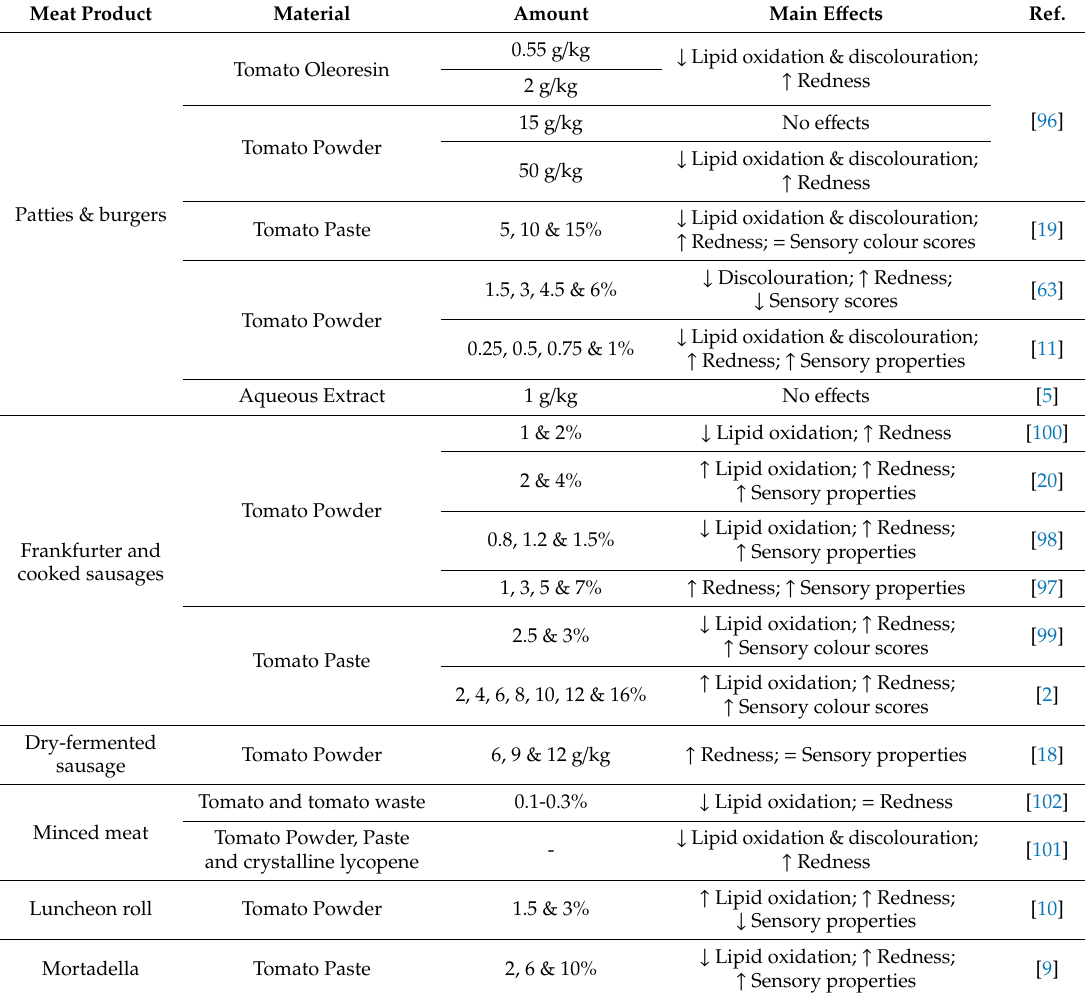
Table 3. Meat products reformulated with tomato